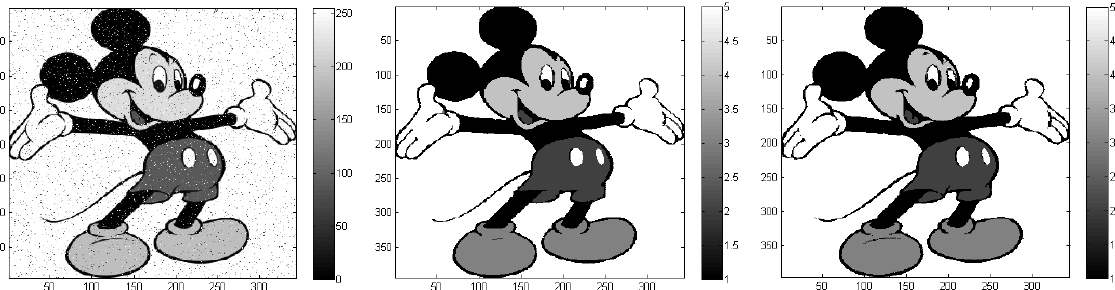
Figure 7. On the ( left ) is the noisy image of Mickey. The denoised images were obtained using MRFs ( middle ) and mode filtering ( right ).